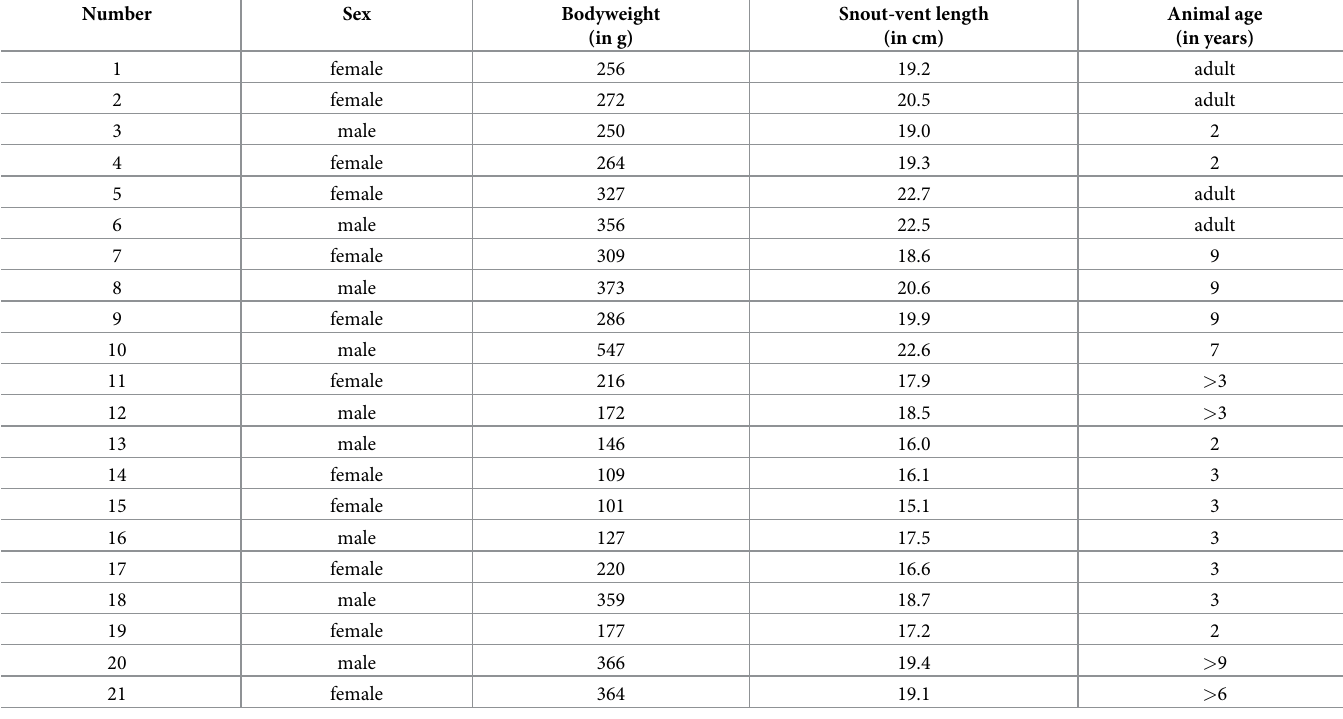
Animal number, gender, bodyweight (g), snout-vent length (SVL) (cm) and age (years) of bearded dragons administered Sodium/Meglumine–Amidotrizoate (SMAT, Gastrografin).